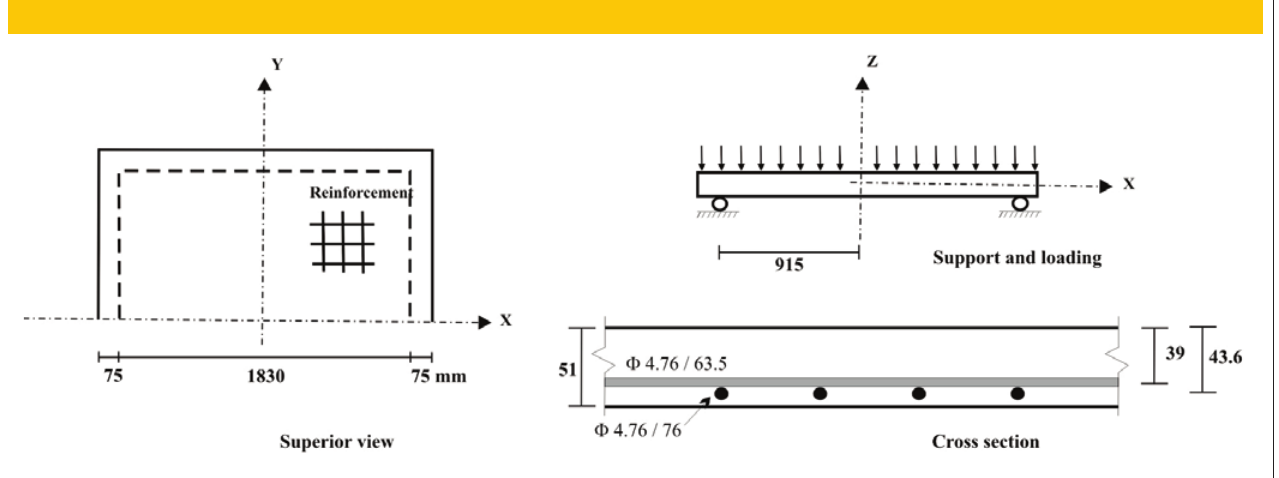
Figure 7 – Geometry, structure and material parameters of RC-slab according to